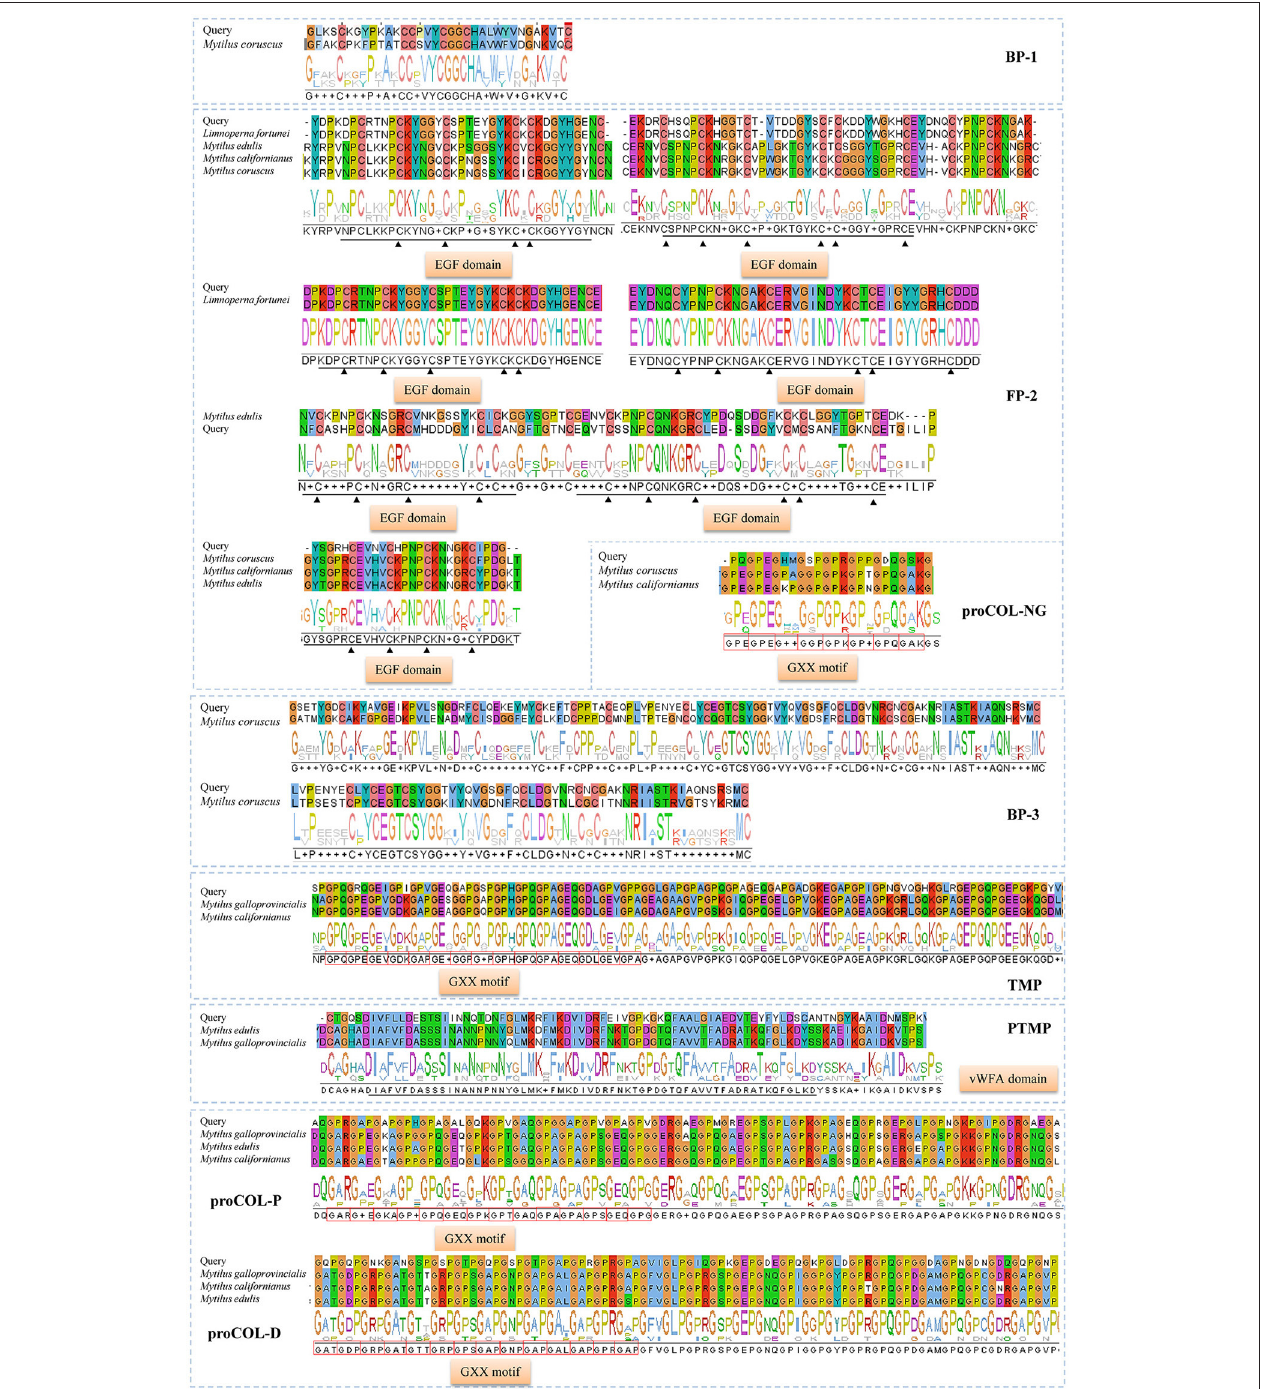
FIGURE 3 | Homologous alignments of foot protein genes identified from foot transcriptome of Limnoperna fortunei . Alignment result for each gene contains similarity regions of amino acids (shadow) and consensus logo (below the shadow). The regions marked by black straight lines and triangles are conserved EGF domains and the red boxes indicate GXX motifs. The amino acid sequences used for these alignments are as follows. Bp-1: Mytilus coruscus [AKI87984.1]; Fp-2: Limnoperna fortunei [BAO74176.1], Mytilus edulis [AAX23970.1], Mytilus californianus [AST36139.1] and Mytilus coruscus [ALA16015.1]; Bp-3: Mytilus coruscus [AKI87986.1]; proCOL-NG: Mytilus coruscus [ALA16018.1] and Mytilus californianus [ABW90433.1]; proCOL-D: Mytilus galloprovincialis [AAM34601.1], Mytilus californianus [ABW90432.1] and Mytilus edulis [AAB96638.1]; proCOL-P: Mytilus galloprovincialis [AAM34600.1], Mytilus edulis [AAB80719.1], and Mytilus